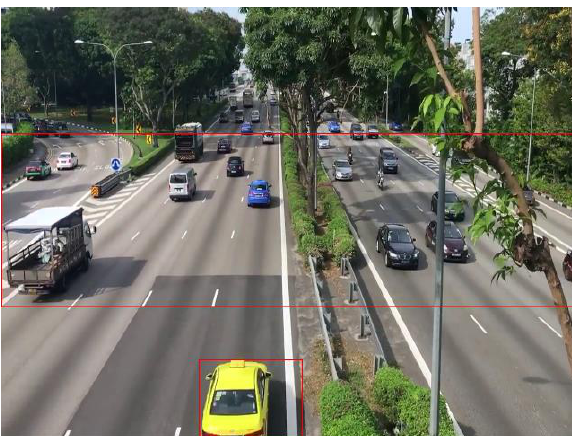
Fig. 1. Illustration of the motion detector algorithm. Vehicles collision is detected (marked with rectangle).